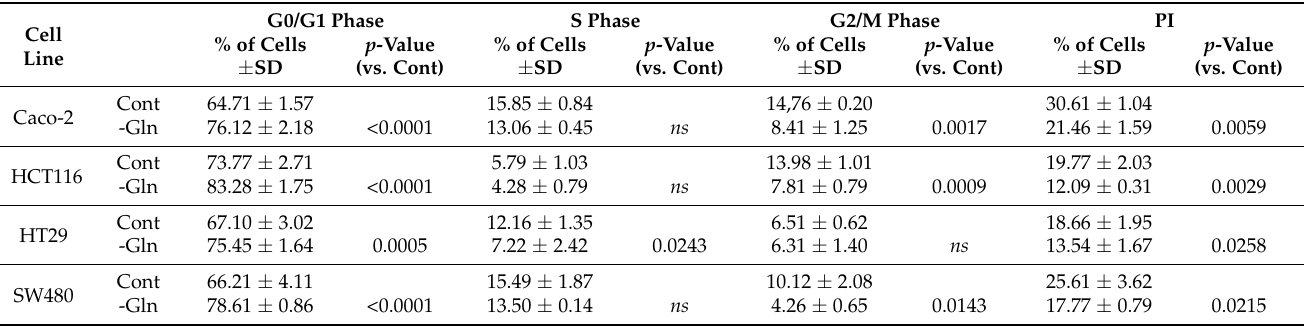
Table 4. Glutamine-starvation-induced cell cycle